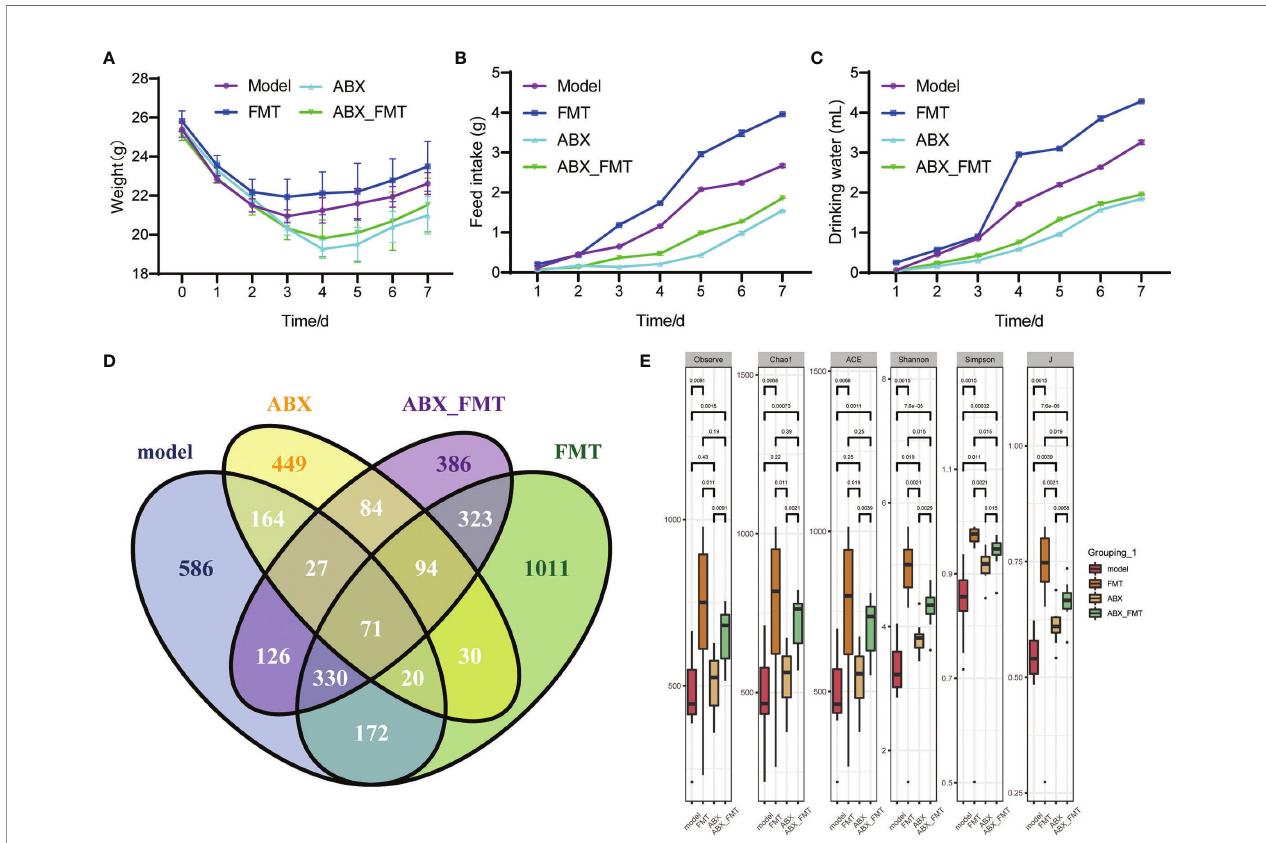
FIGURE 4 | FMT improved physiological characterization and gut microbiota diversity in mice with acute pneumonia (n=10 mice/group). (A-C) Body weight, food and water intake of mice were observed and monitored for 7 days. (D) The quantitative analysis of common and endemic microbiota. (E) Alpha diversity index. N=5 sample/group for 16S rRNA